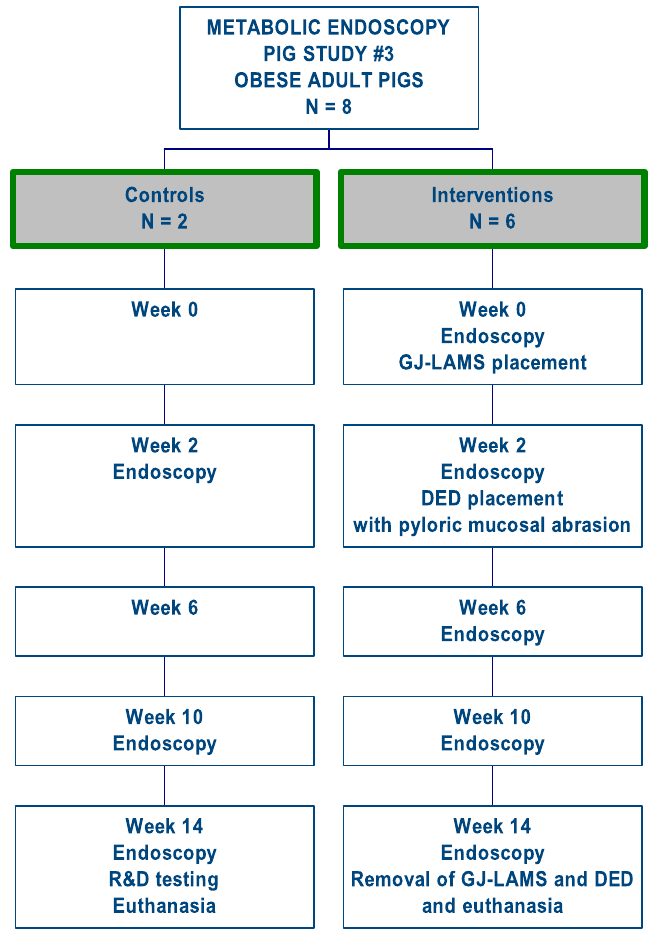
Figure 1. Study flow chart. GJ-LAMS gastrojejunostomy lumen-apposing metal stent, DED duodenal exclusion device, R&D research and